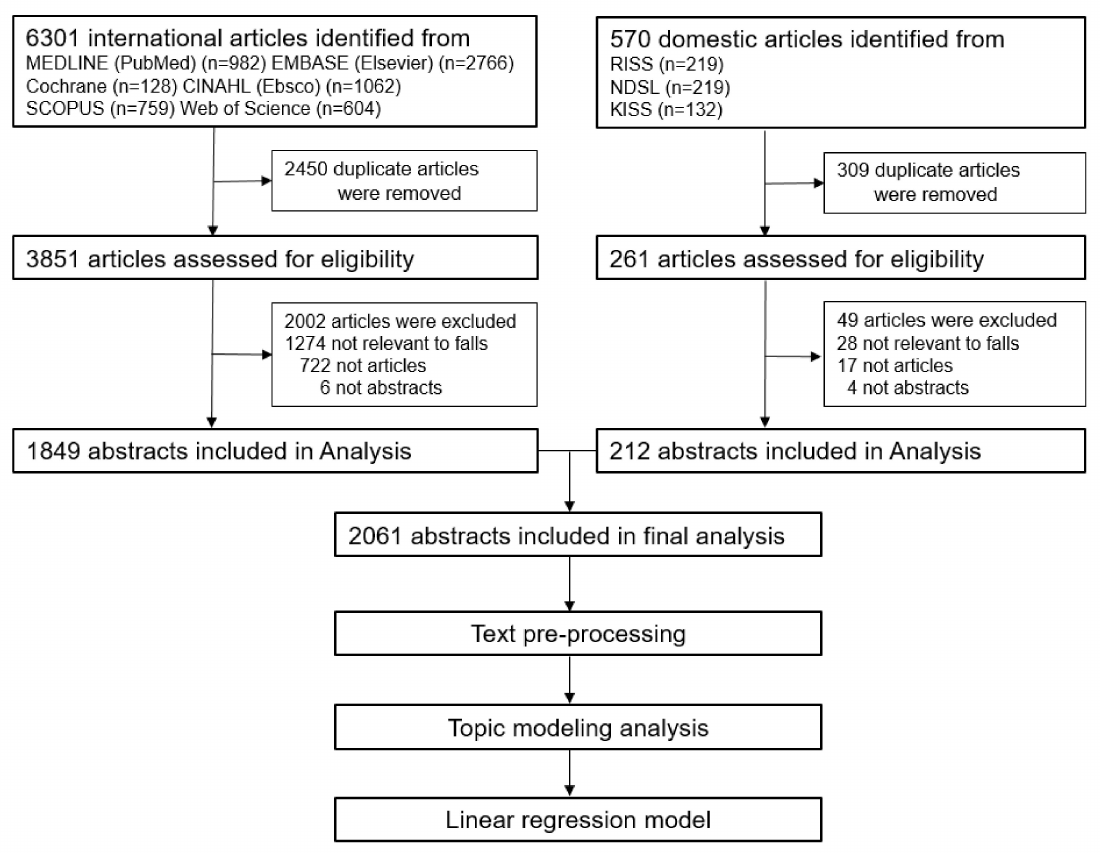
Figure 1. Research